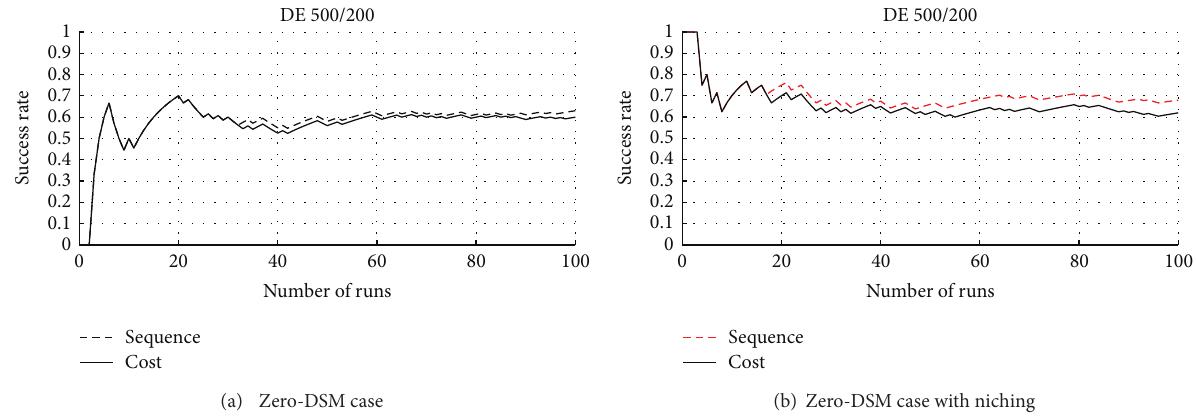
Figure 8: The success rate for finding the optimal cost and swing-by sequence, for the Cassini 2 mission.